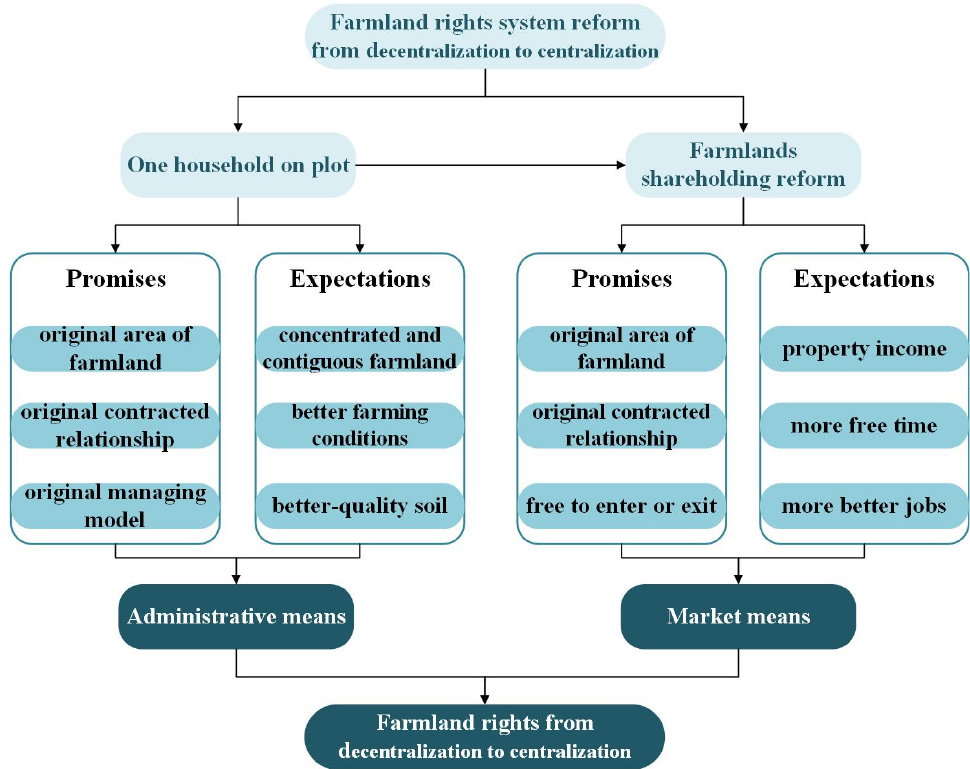
Figure 4. The farmland rights system reform in Yuyang District.